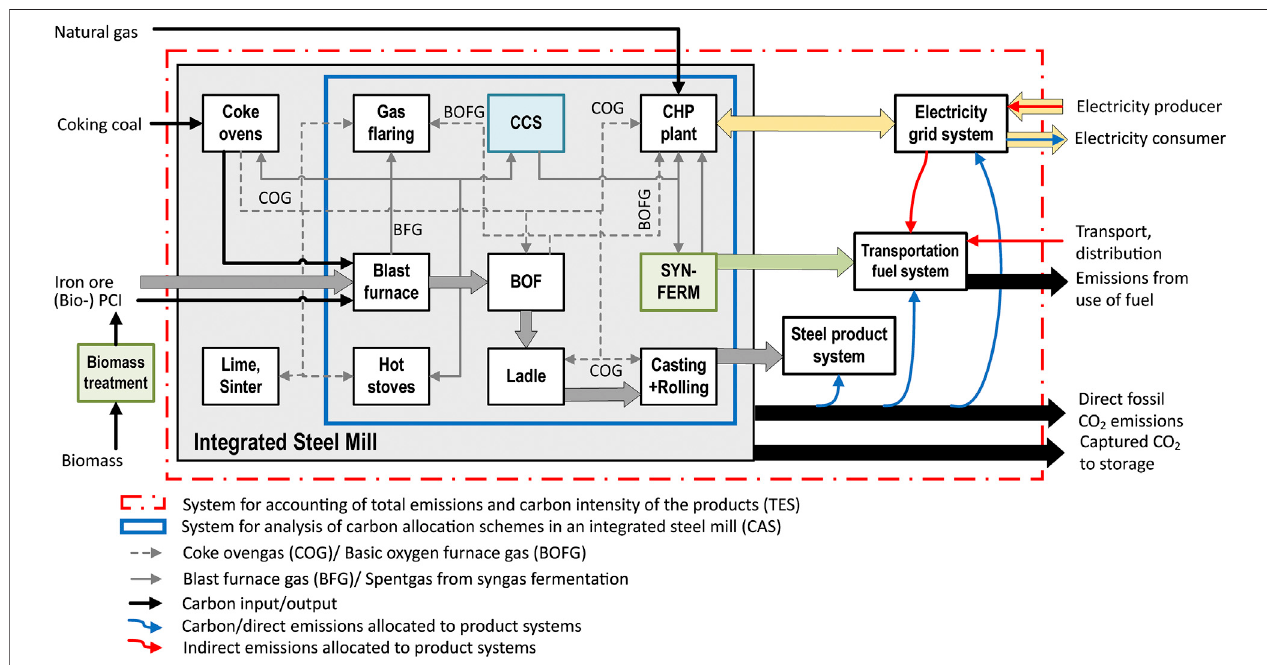
FIGURE1| Overviewofthesystemsconsideredinthepresentstudy.Anintegratedsteelmillwithmajorprocessunits(whiteboxes), itscarbon-rich streams(black and grey), and its products, which are supplied to three product systems (thick arrows). The considered mitigation technologies of CCS, biochar injection (Bio-PCI) and